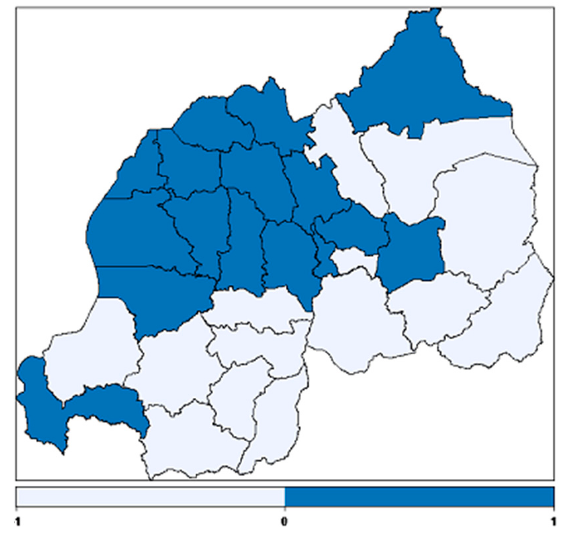
Figure 5. Structured spatial effects on childhood hemoglobin concentration where dark blue colour regions depicts lower risk and light blue depicts higher risk of anemia.